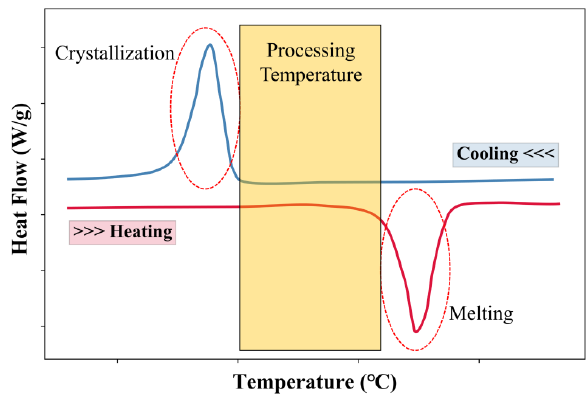
Figure 7. Typical differential scanning calorimetry (DSC) traces of thermoplastic polyurethane (TPU) material.